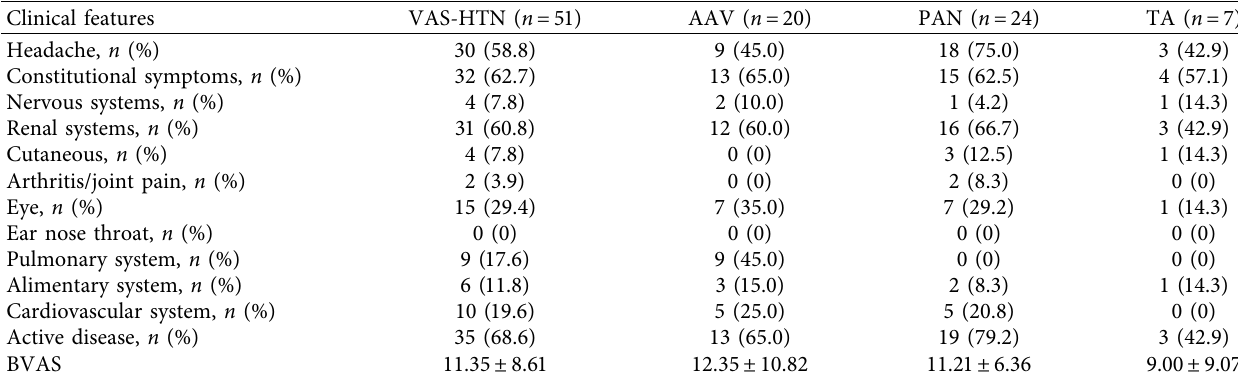
Table 2: Clinical features of patients with vasculitis combined with